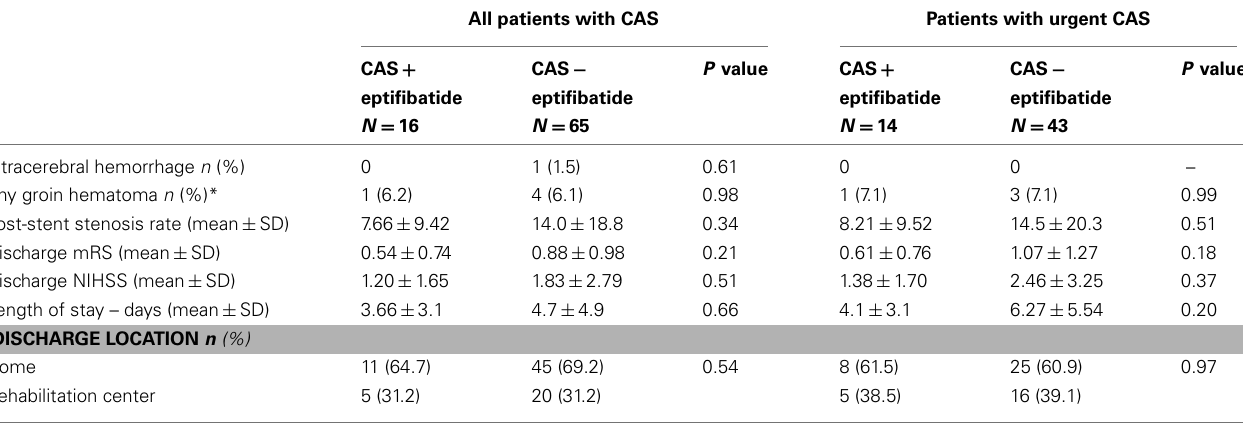
Table 2 | Outcomes associated with carotid artery stenting (CAS) in association with the use of eptifibatide among all patients, and a subgroup of patients with acute stroke or transient ischemic attacks followed by urgent